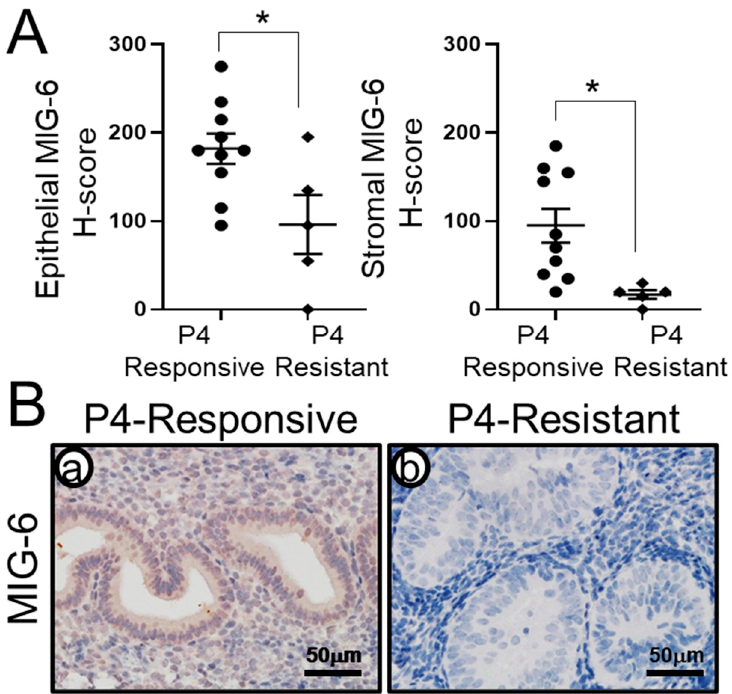
Figure 2. Upregulation of MIG-6 expression is important to overcome P4 resistance in human. ( A ) H-score of MIG-6 showed that MIG-6 expression is significantly higher in P4-responsive women (n = 10) compared to P4-resistant women with CAH or EEC (n = 5) after P4 treatment. ( B ) Representative MIG-6 expression in P4-responsive (a) and P4-resistant (b) women by immunohistochemistry. *, p < 0.05.